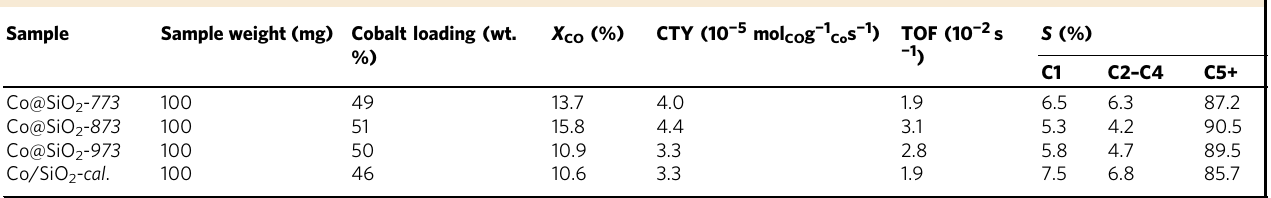
Table 2 Catalytic performance of Co@SiO 2 catalysts after 102 h TOS Sample Sample weight (mg) Cobalt loading (wt.